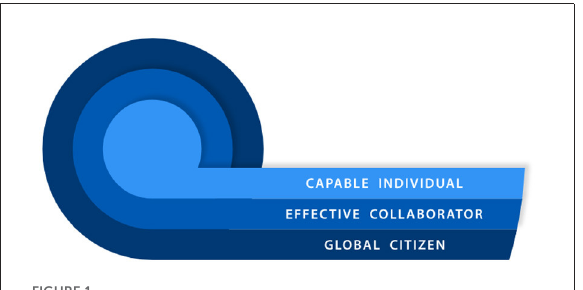
FIGURE1 Bond University graduate attributes: capable individual, effective collaborator, and global citizen